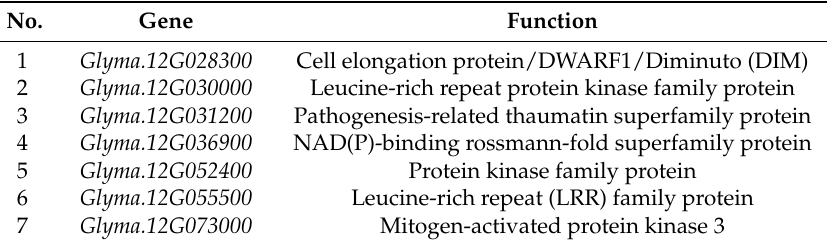
Table 4. Annotation of candidate genes might interact with NopP.